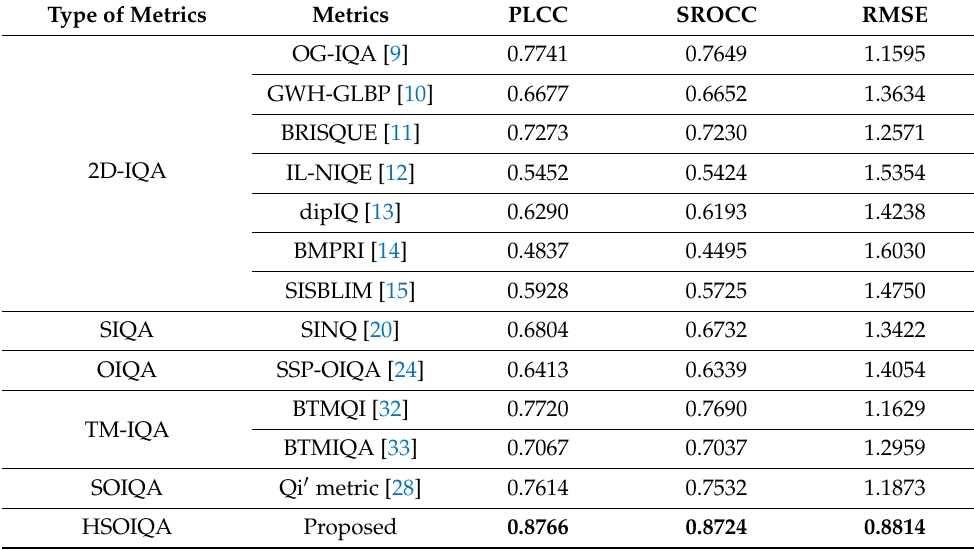
Table 6. Objective assessment results of different metrics on the HSOID